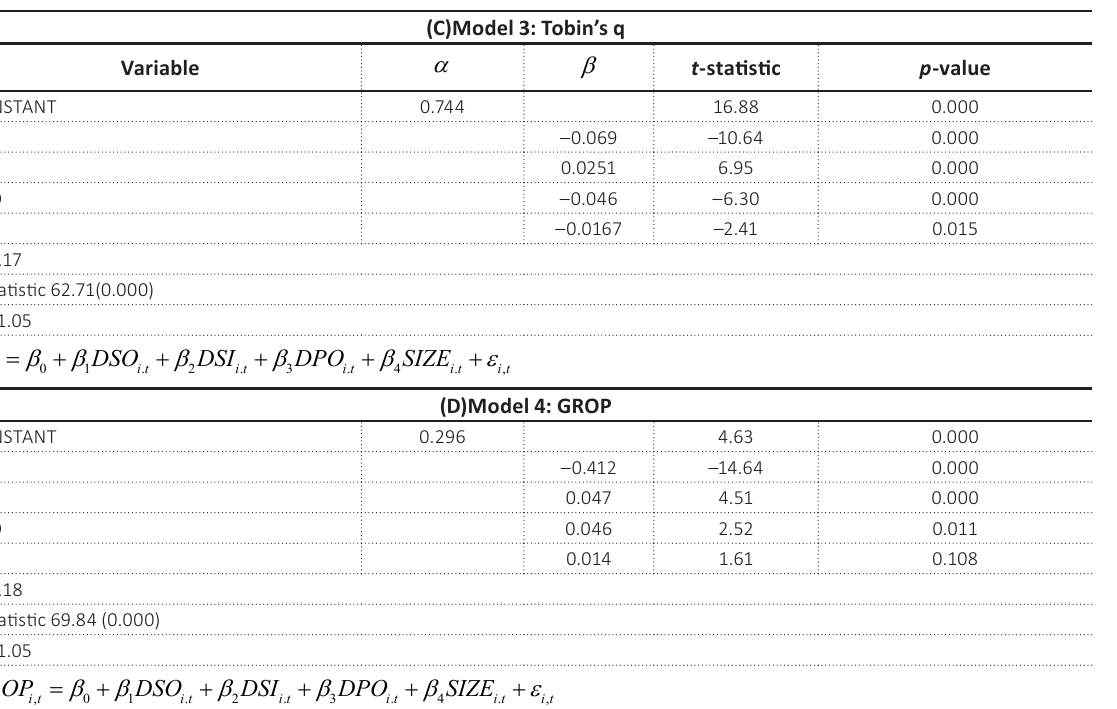
Table 5. Result of regression analysis